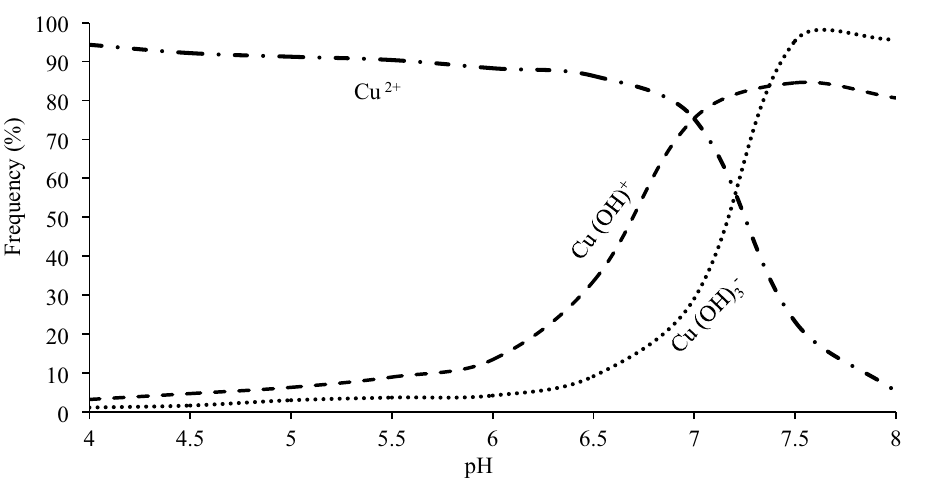
Figure 4. Copper speciation in equilibrium solution using visual MINTEQ (ionic strength 0.01 M CaCl 2